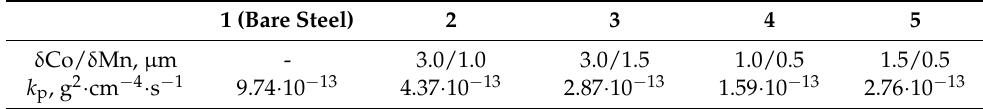
Table 4. Values of the oxidation rate constants of studied